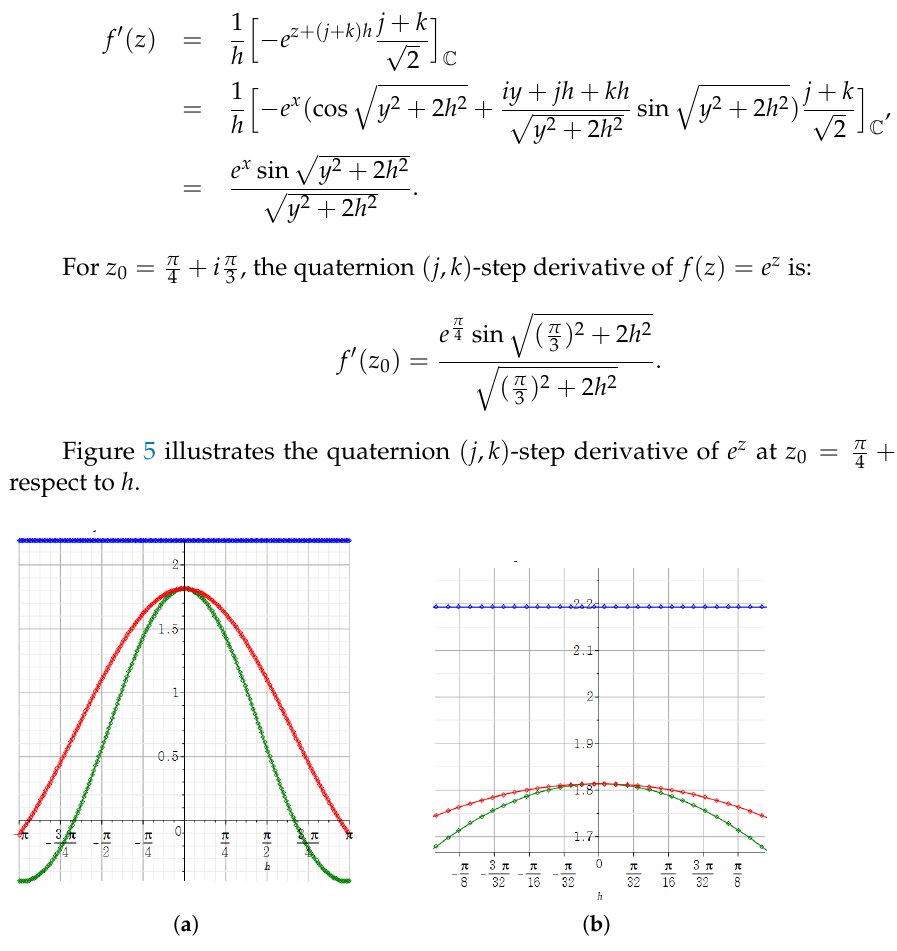
Figure 5. ( a ) The result obtained by using the Maple plot to see what the step derivative has according to the size of h . ( b ) In the graph of ( a ), the result of zooming in about h near zero. In ( a , b ), according to the size of h , the green graph represents the ( j , k ) -step derivative, the red graph represents the j -step derivative of e z at z 0 , and the blue constant graph represents the absolute value of the derivative of e z at z 0 by the definition of the derivative for a complex